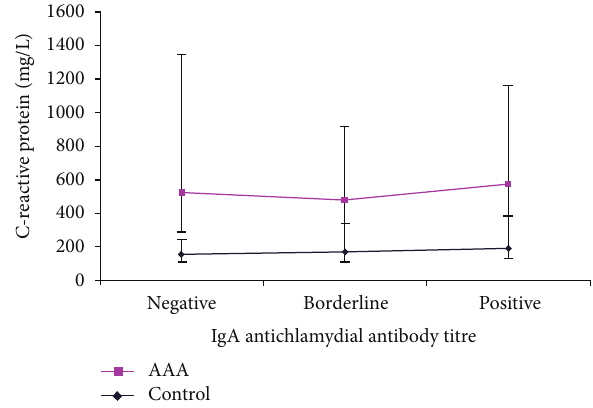
Figure 2: C-reactive protein in control versus AAA groups at different IgA antichlamydial antibody titres: negative ( 𝑃 = 0.002 ), borderline ( 𝑃 = 0.018 ), and positive ( 𝑃 = 0.0001 ) expressed as median and IQR (Mann-Whitney 𝑈